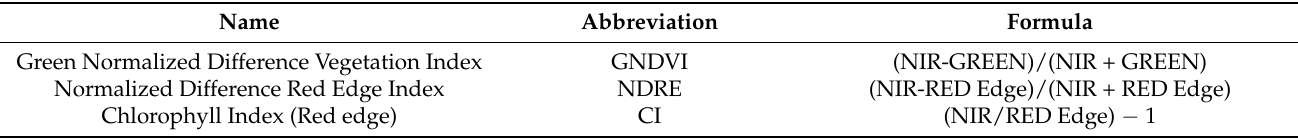
Table 2. Information from the spectral index map used in this